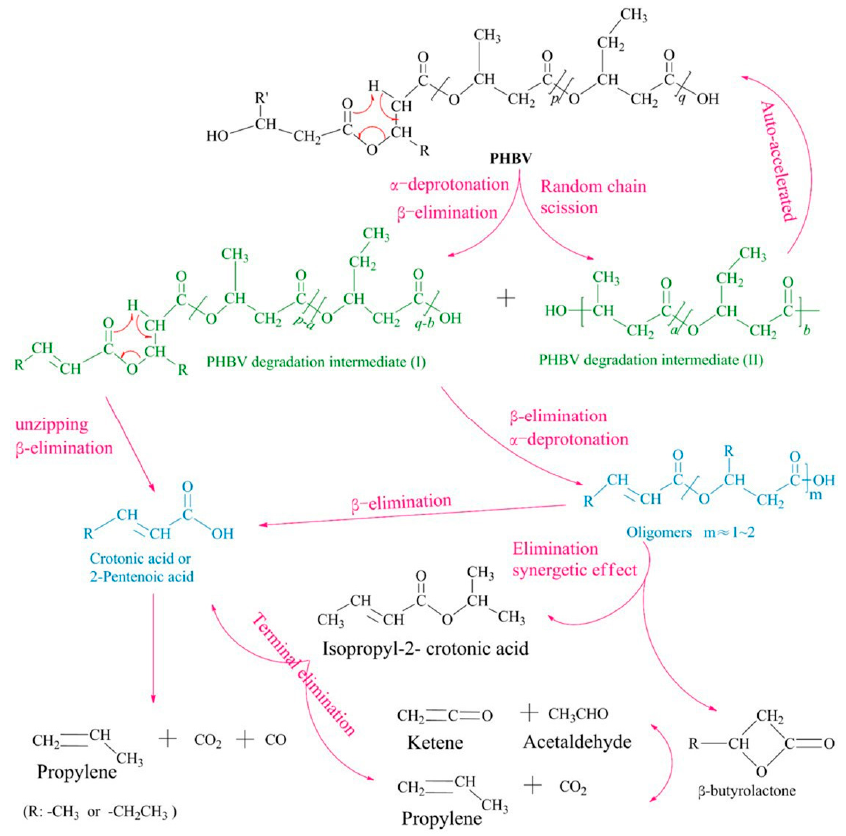
Figure 5. Schematic diagram of PHBHV thermal degradation. Reprinted with permission from